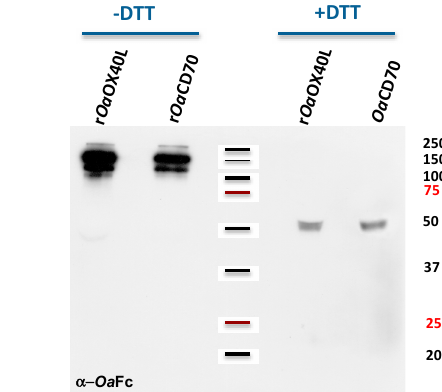
Figure 3. Expression and secretion of r Oa OX40L and r Oa CD70 using recombinant adenoviruses. ( A ) Vero cell monolayers were not infected (mock) or infected with the recombinant Ad5- Oa OX40L, Ad5- Oa CD70, or the control Ad5-DsRed viruses as indicated. At 48 hpi, the cells (C) and media (M) were harvested separately and equivalent amounts analysed by Western blot for the presence of ovine Fc-bearing proteins (upper panel) or tubulin (lower panel). The r Oa OX40L and r Oa CD70 molecules are readily detected both in the cell extracts and in the media, showing that the proteins are secreted from the infected cells. Absence of cellular tubulin in these media was used as a control of the fractionation procedure. ( B ) The media containing r Oa OX40L and r Oa CD70 from panel A were analysed in the presence or absence of DTT as indicated by Western blot to detect the formation of disulfide linked